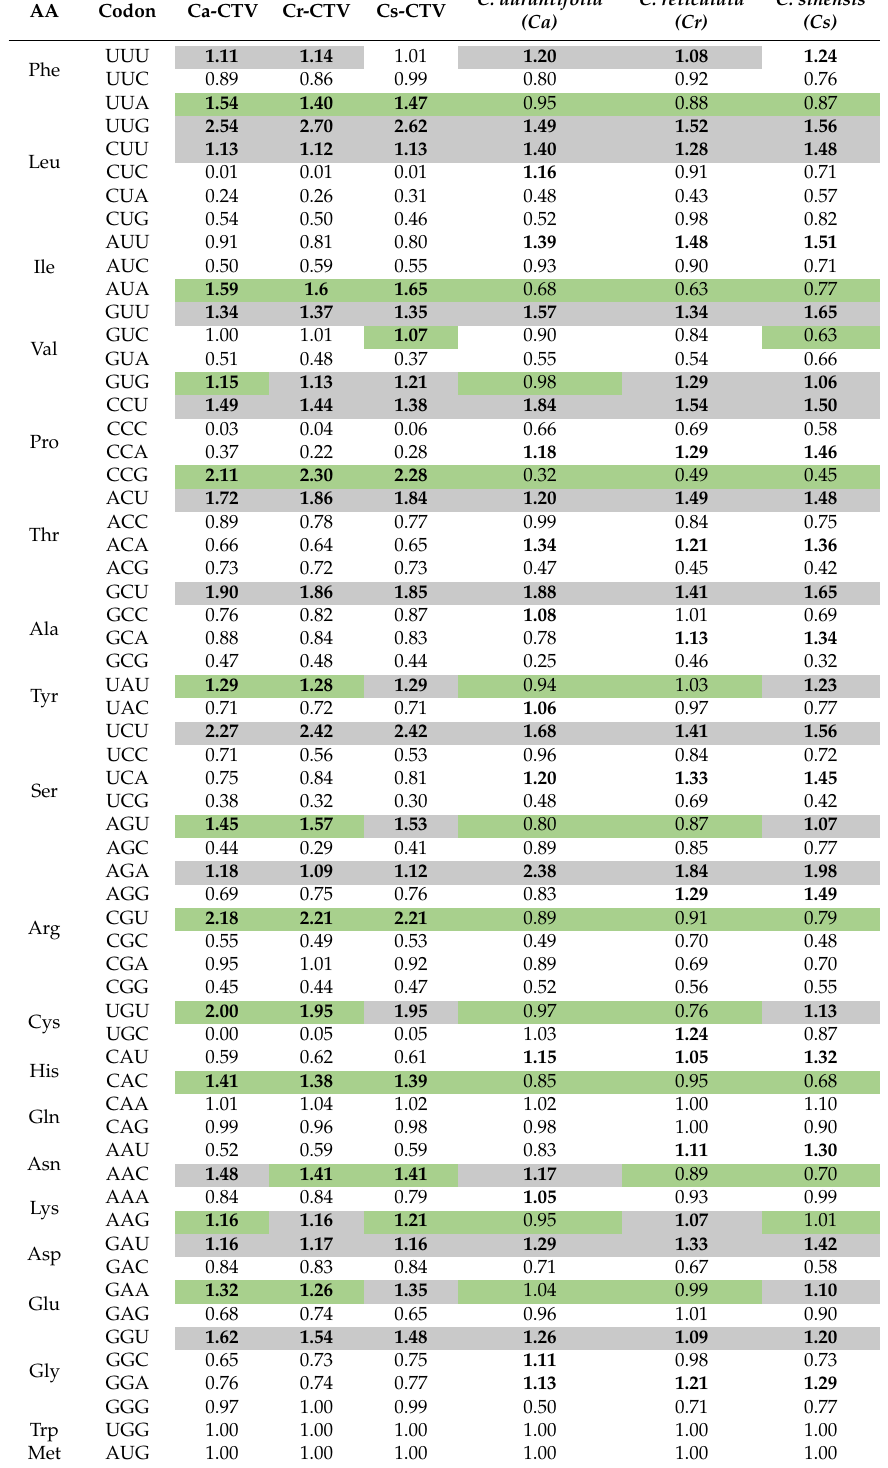
AA represents the three-letter abbreviation code of 20amino acids. Ca-CTV, Cr-CTV, and Cs-CTV denote the CTV isolates originated from C. aurantifolia , C. reticulata , and C. sinensis , respectively. RSCU values of high-frequency codons/abundantly used codons of the virus and its host are marked in bold. Host-preferred high-frequency codons (HFC H ) of CTV showing a coincident relationship with host codons are highlighted with gray color, and the virus-preferred high-frequency codons (HFC V ) of CTV showing an antagonist relationship with host codons are highlighted with green